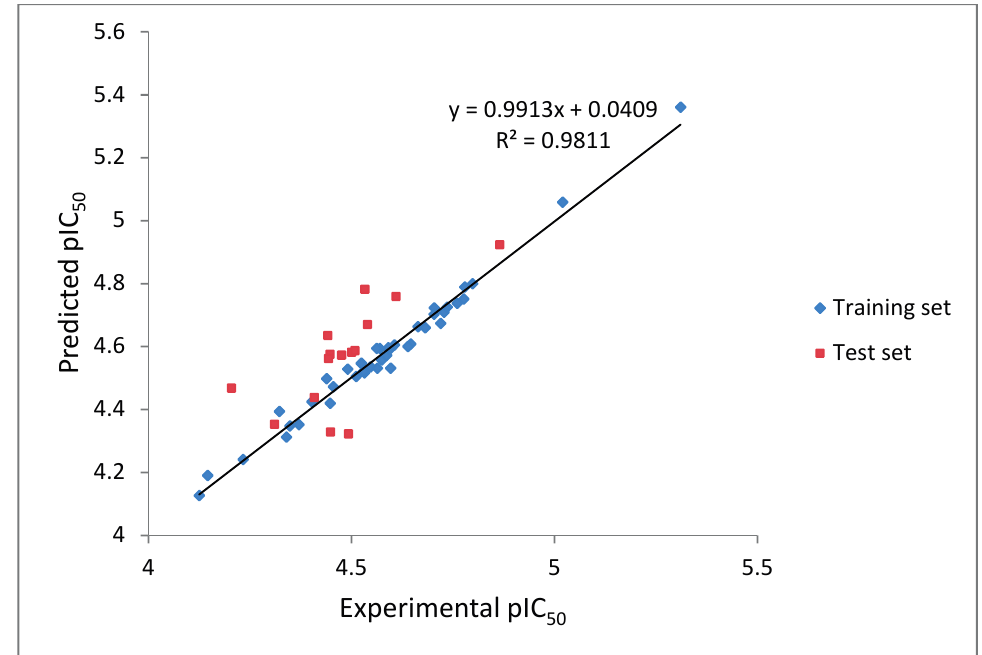
Figure 5. The experimental pIC 50 versus predicted activity plot of training set and test set